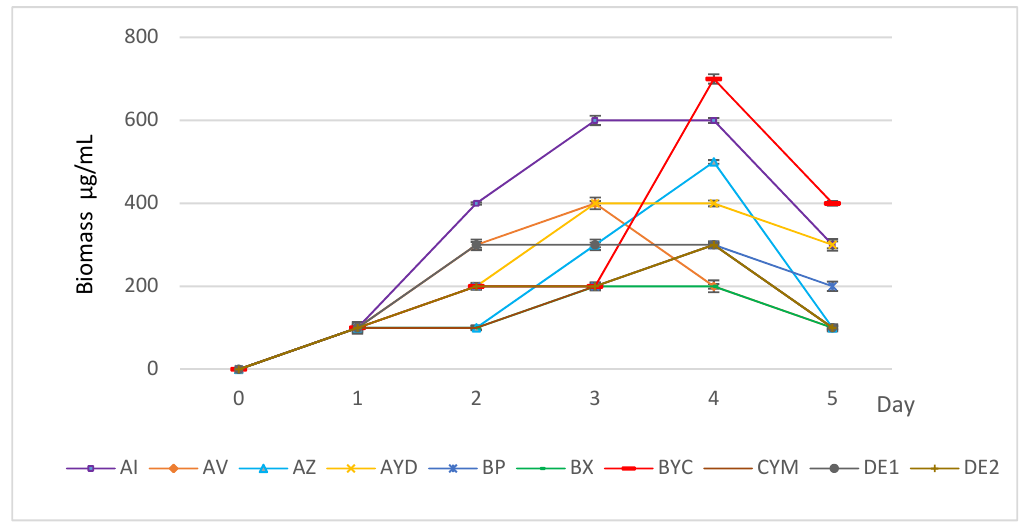
Figure 2. Evolution of the biomass of the selected Actinomycete strains grown in the liquid AMM + orthoclase. Error bars represent standard deviations of the mean values of the results of three independent culture replicates.